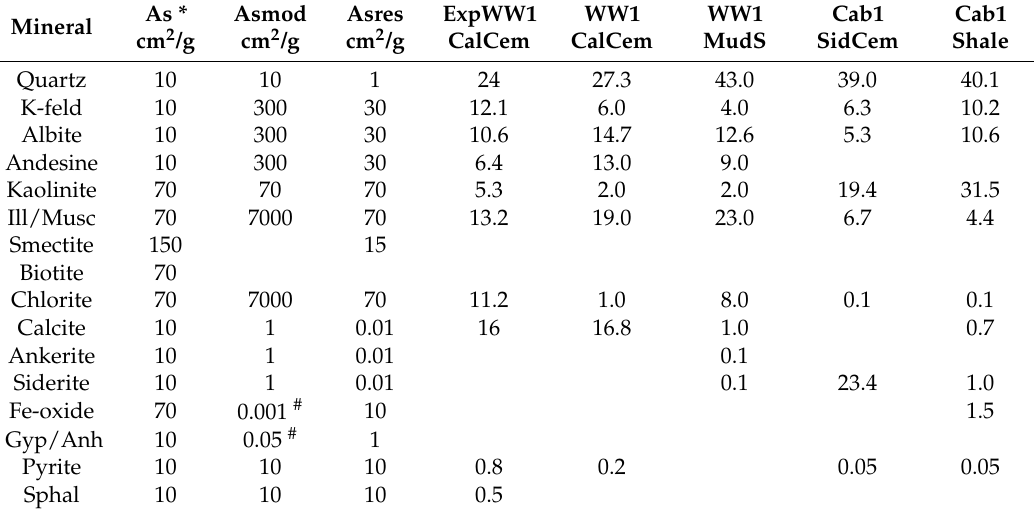
Table 2. Reactive surface areas and mineral proportions used in geochemical models. * As are the initial reactive surface areas assigned to each mineral. Asmod are the modified reactive surface areas to model the experiment data. Asres are the up-scaled reactive surface areas. # Used for precipitation